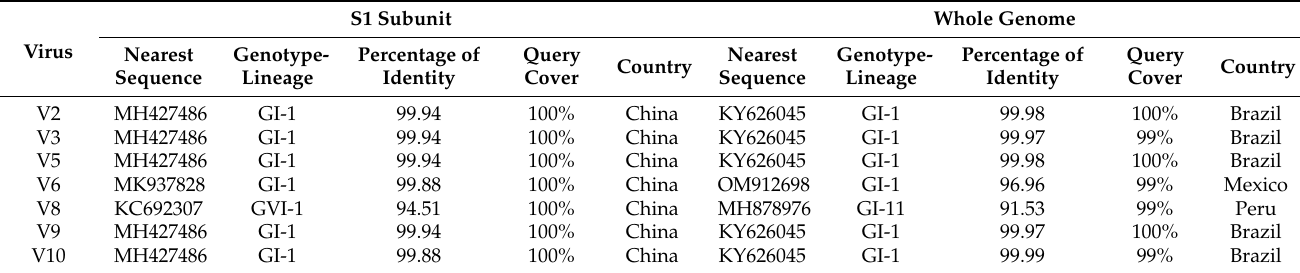
Table 3. Genotypes, lineages, and nearest sequences from IBV isolates obtained in this